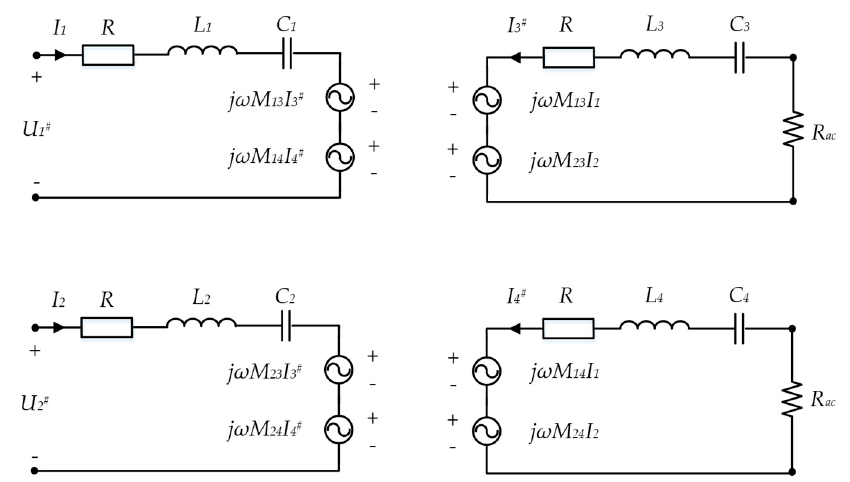
Figure 4. Equivalent circuit in a situation where mutual inductance between receivers is neglected.